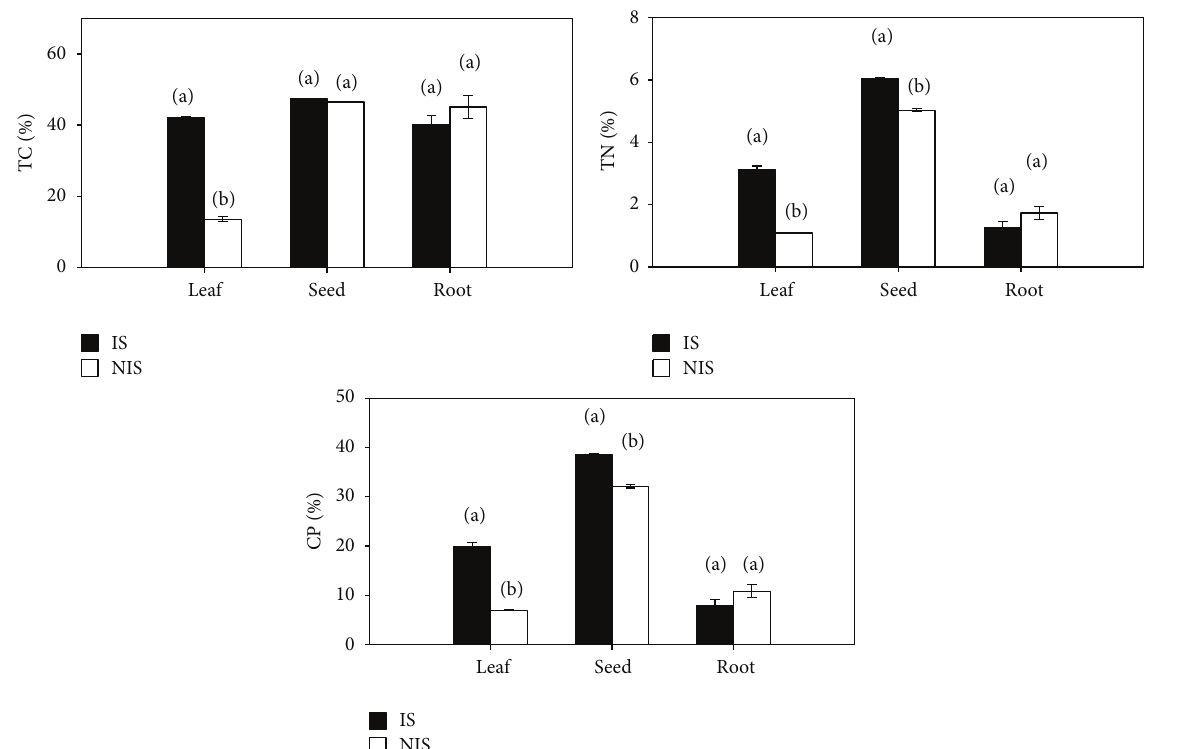
Figure 5: TN%, TC%, and CP% of leaves, seeds, and roots after harvest. Different lower case letters indicate a statistically significant difference at 𝛼 = 0.05.